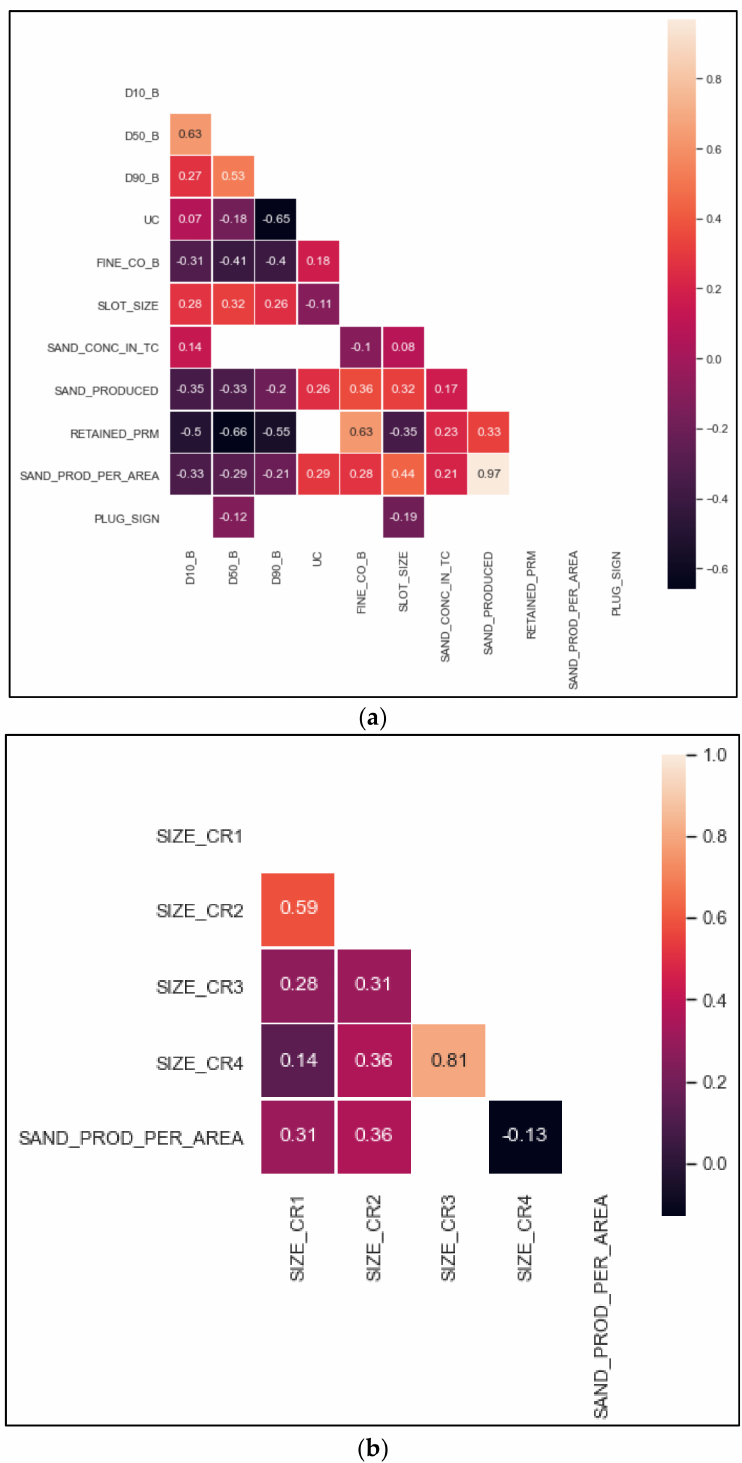
Figure 4. Heatmap plot of SRT variables. ( a ) Correlation analysis of continuous slurry test variables; ( b ) correlation analysis of continuous sand pack test